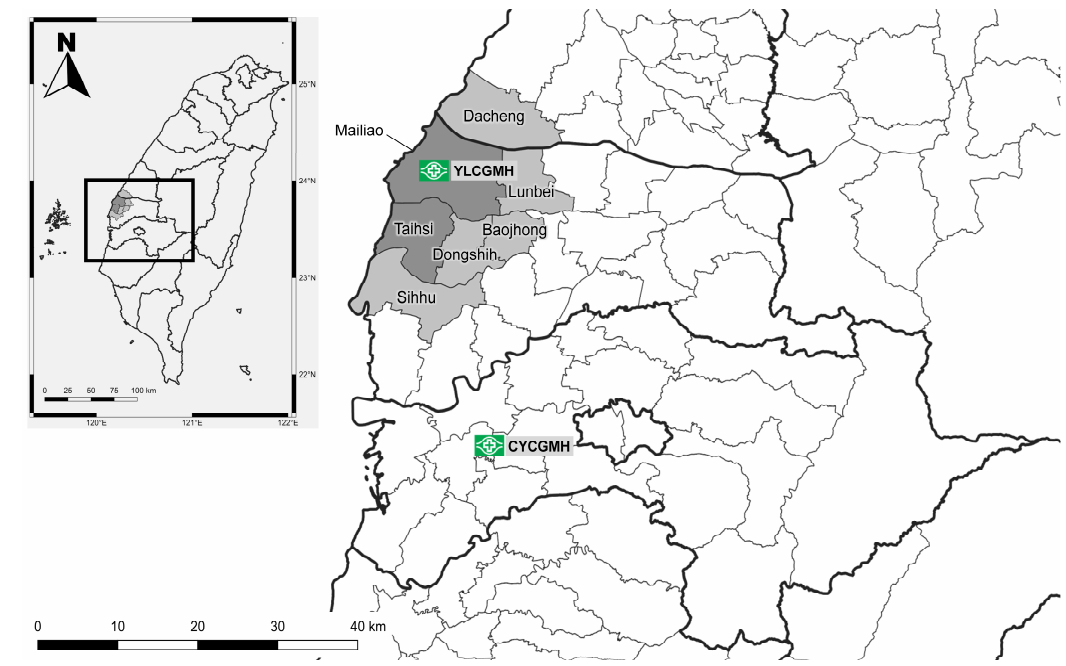
Figure 1. Screening and linkage to accessible care.